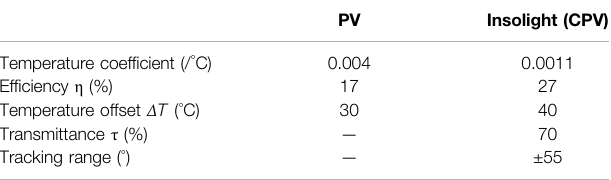
TABLE 3 | Fixed parameters of the PV and CPV module in study.